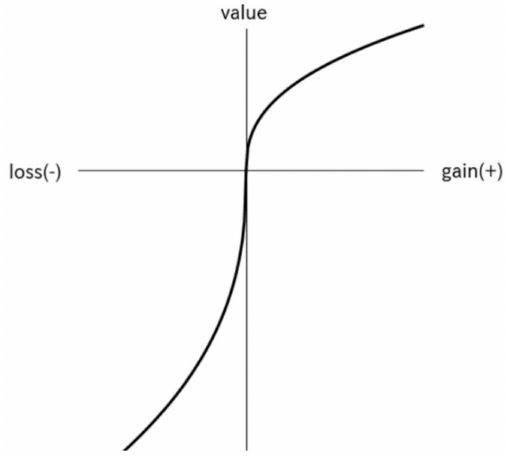
Figure A1. The Value Function (based on [30]).